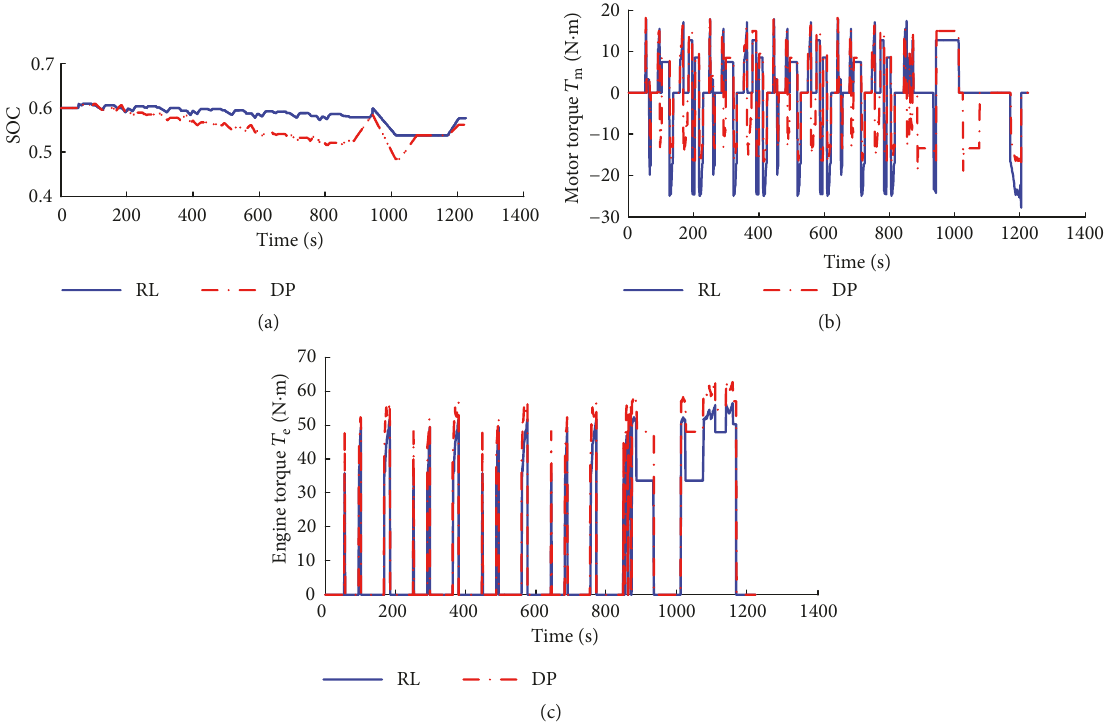
Figure 12: Comparison between DP and RL optimization results based on ECE EUDC.